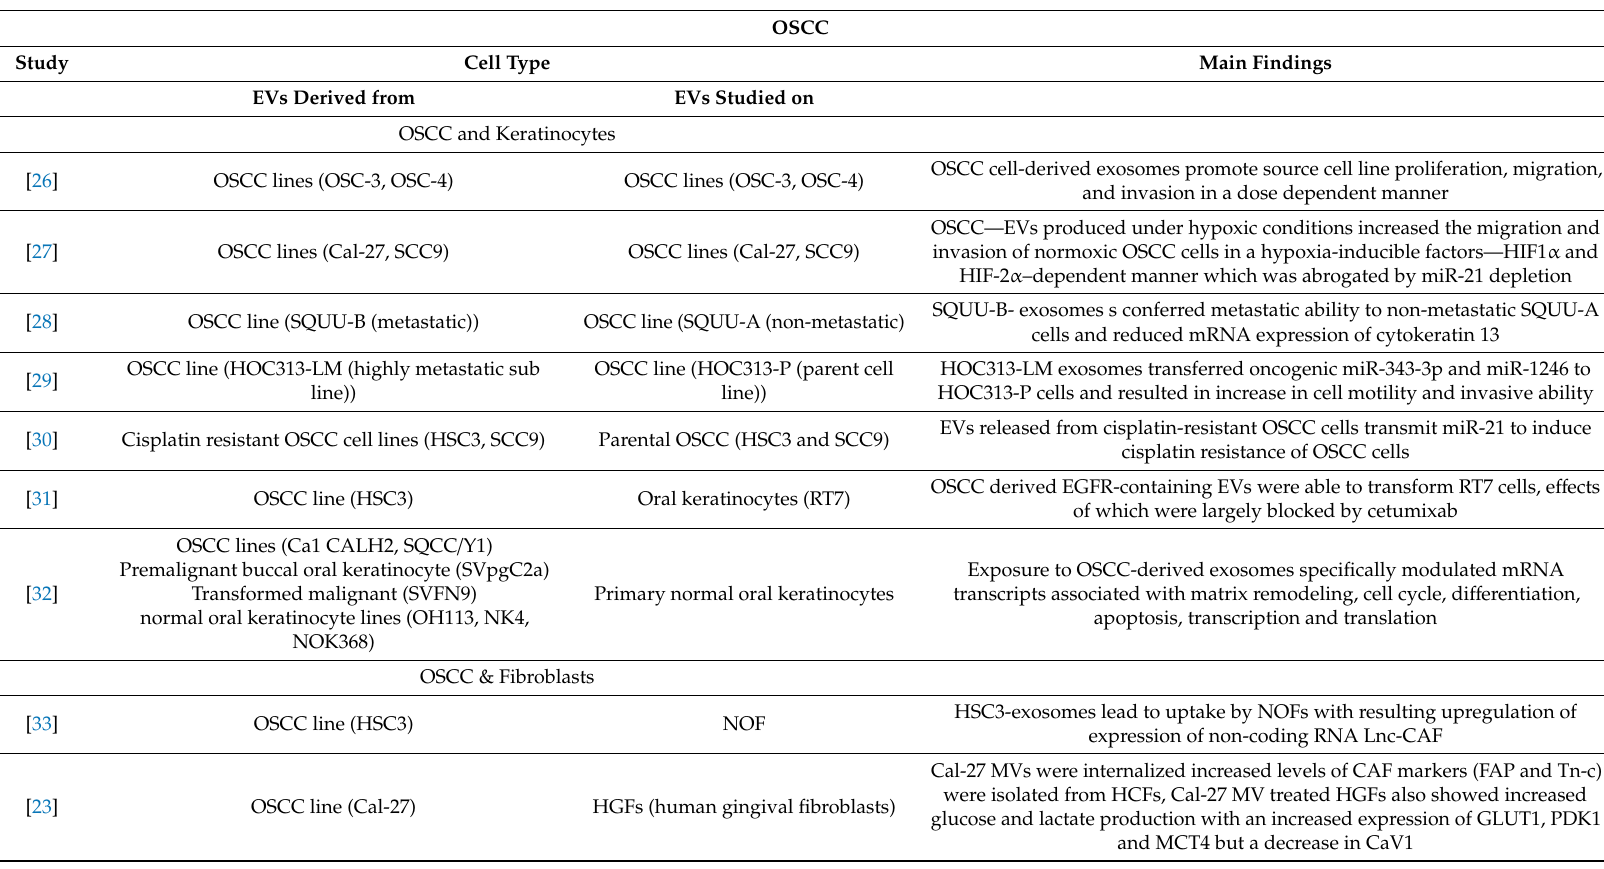
Table 2. Findings from eligible studies assessing EVs in cell-based